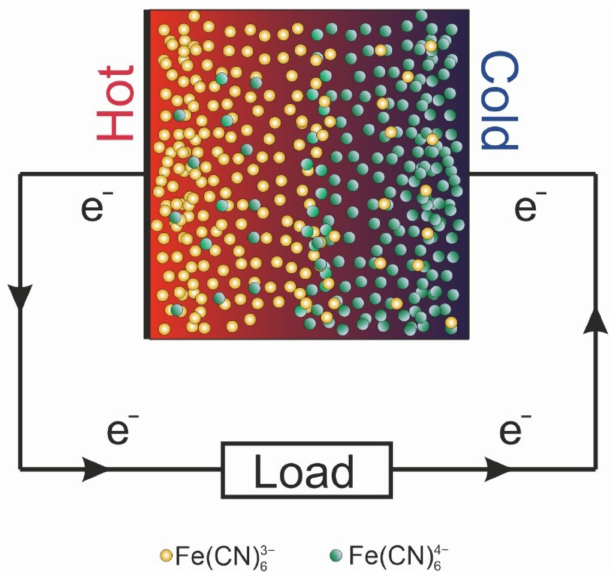
Figure 3. Schematic of a thermoelectrochemical cell with a [Fe(CN) 6 ] 3 − /[Fe(CN) 6 ] 4 − redox